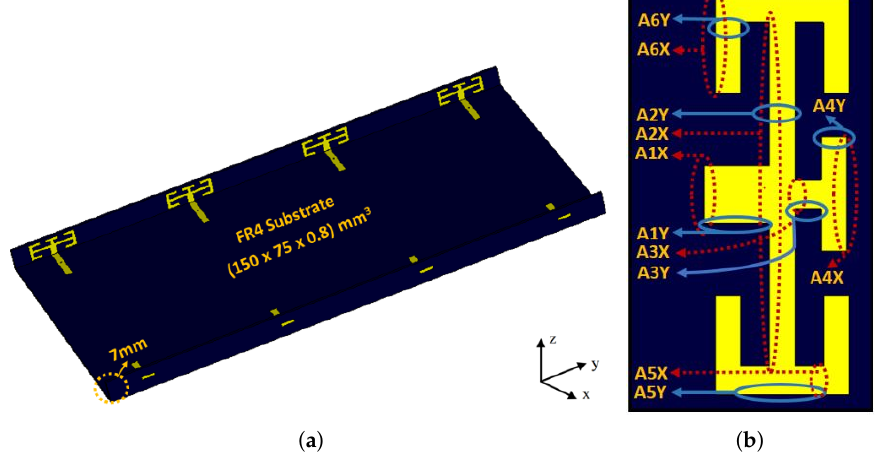
Figure 1. ( a ): Perspective view of the proposed Multiple Input Multiple Output (MIMO) system, ( b ): single monopole antenna element.